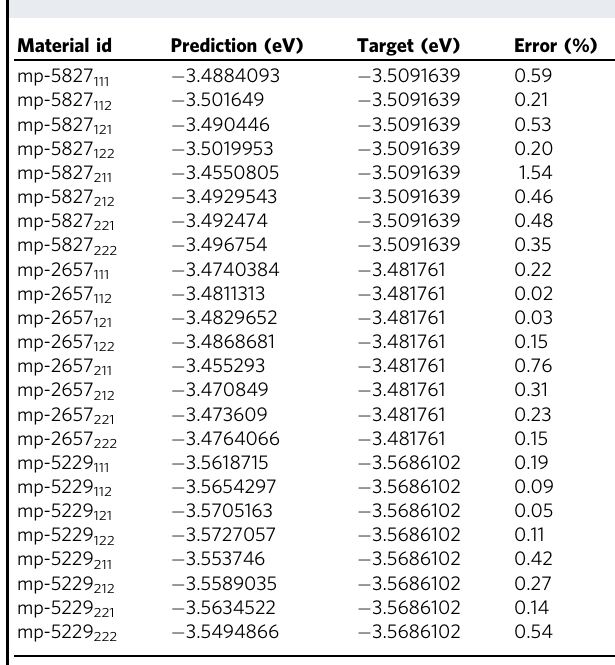
Table 2 Predictions ( E three crystal